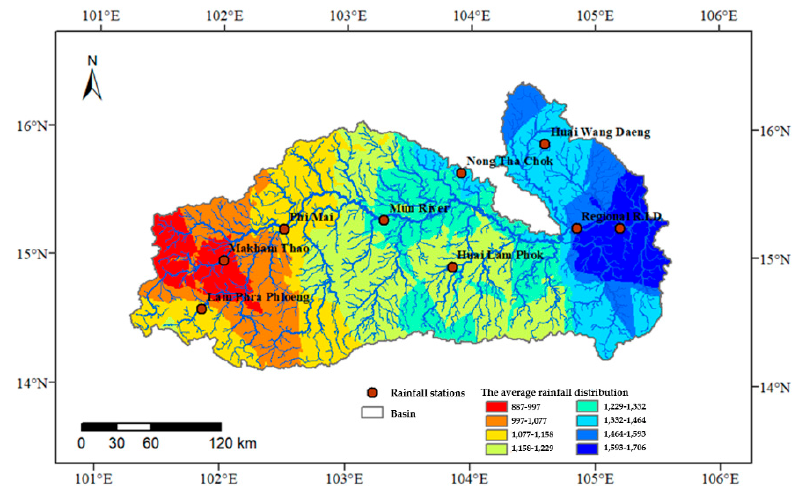
Figure 2. Spatial distribution of mean annual rainfall in the Mun River basin based on observations during 1980–2015.